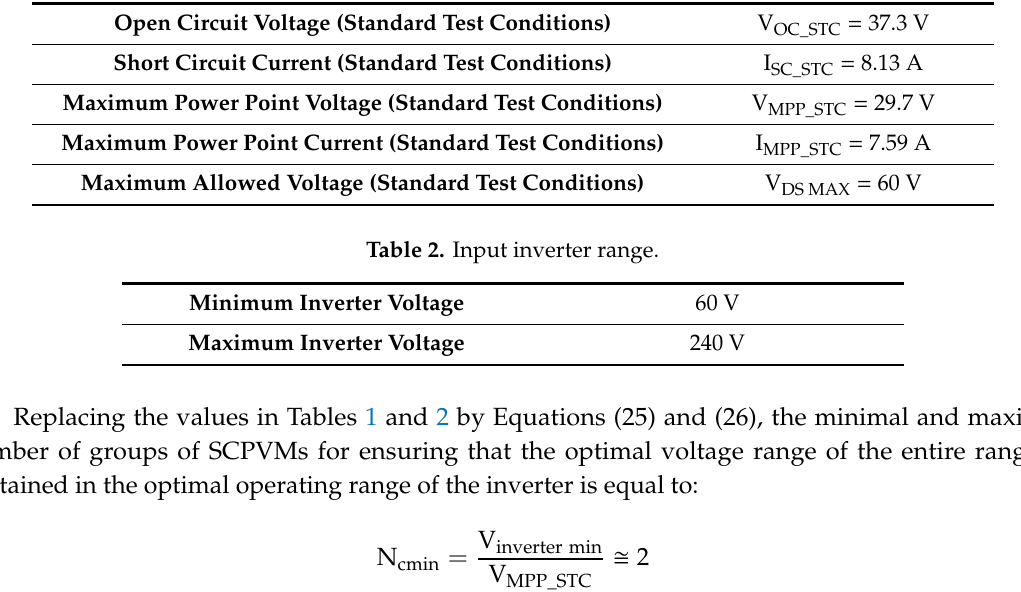
Table 1. Electrical characteristics of the SCPVMs.